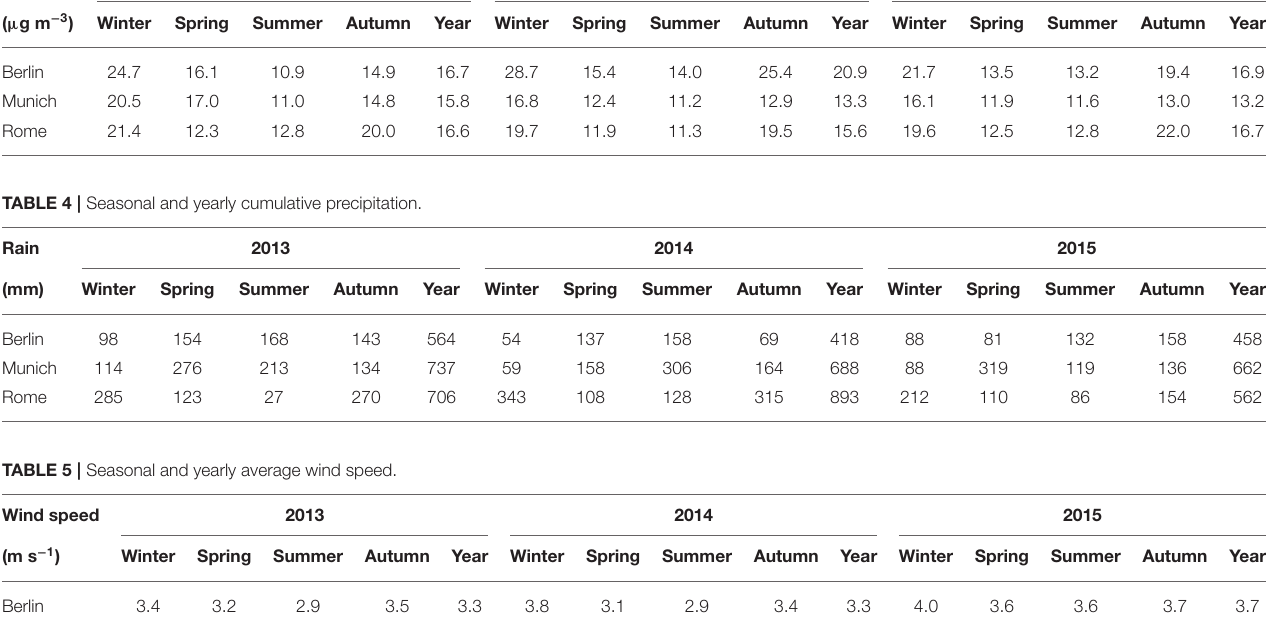
TABLE 3 | Seasonal and yearly PM 2.5 average concentration. PM 2.5